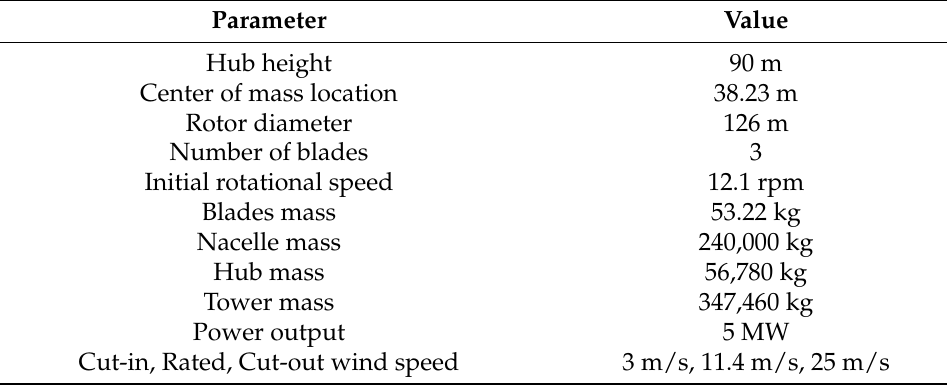
Table 1. 5-MW floating wind turbine Features